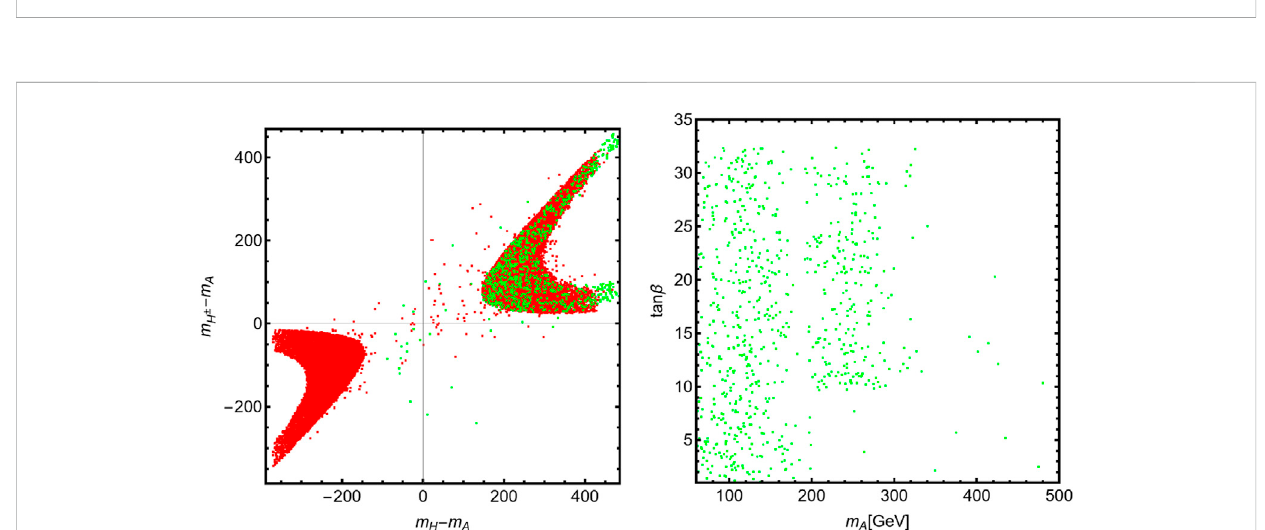
FIGURE 8 Another view of the model points that have been shown in Figure 7 (red points) and those that are also complying with the LHC constraints from additional Higgs boson searches (green points) in the ( M H − M A , M H ± − M A ) plane (left panel) and in the ( M A , tan β ) plane (right panel). Details are given in the